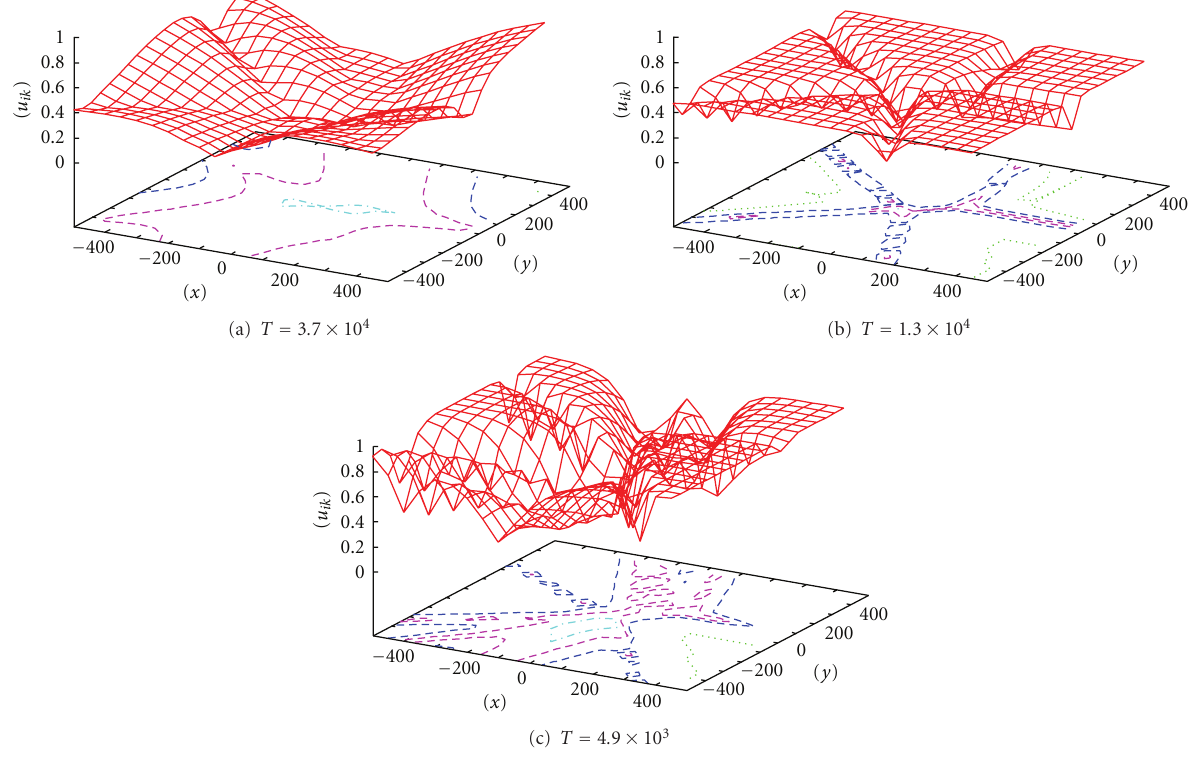
Figure 9: The changes of the landscape of u ik with decreasing the temperature.